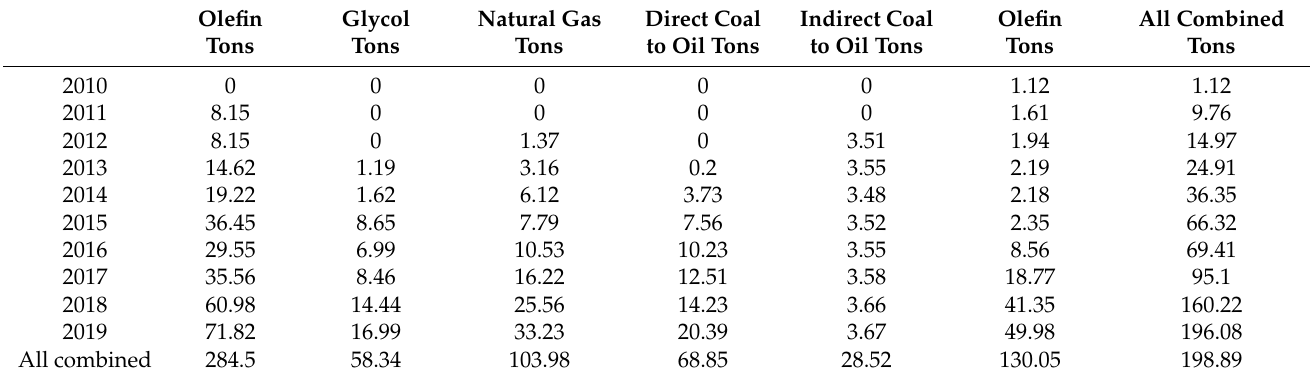
Table 6. Carbon emissions of chemical